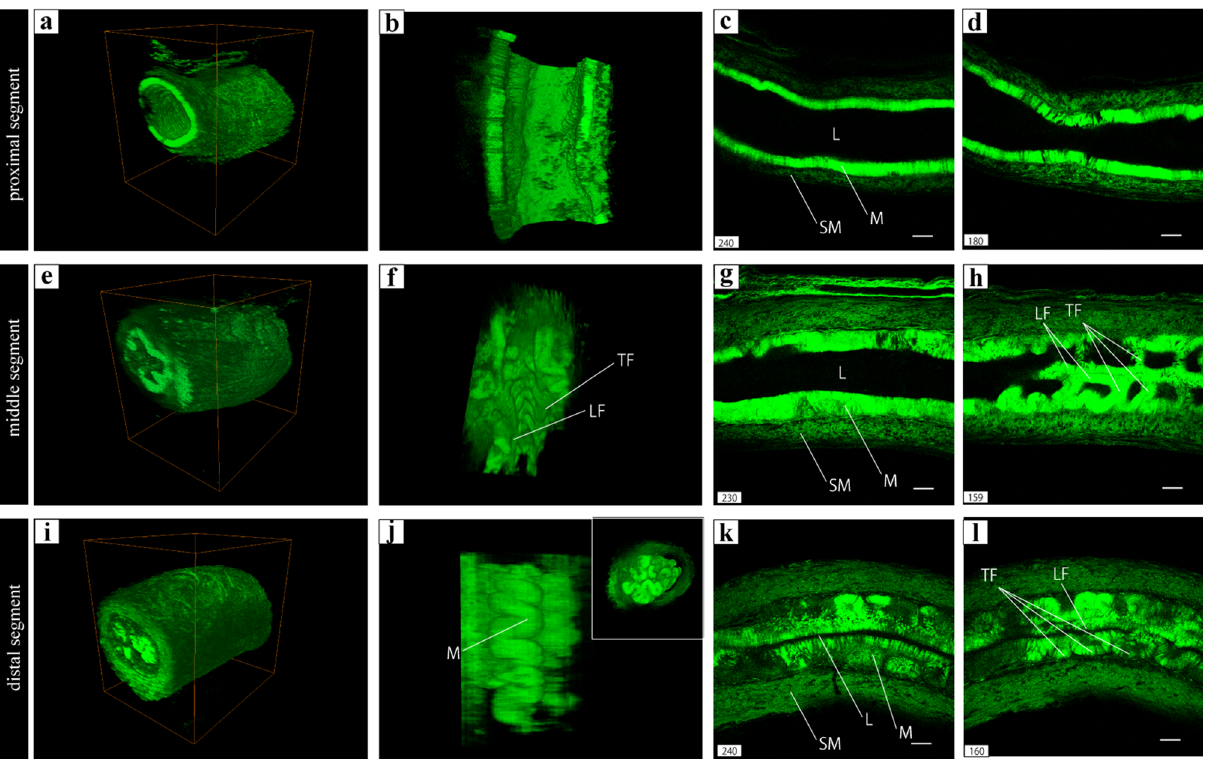
Figure 1. ( a ) The 3D reconstructed overview of the proximal segment of GFP transgenic murine vas deferens. ( b ) Lumens of ( a ). ( c , d ) Sagittal sections including the lumen of ( a ). ( e) : 3D reconstructed overview of the middle segment of GFP transgenic murine vas deferens. ( f ) Lumens of ( e ). ( g , h ) Sagittal sections including the lumen of ( e ). ( i) : 3D reconstructed overview of the distal segment of GFP transgenic murine vas deferens. ( j ): Side view of the mucosa area of ( i ). Front view of the mucosa area of ( i ) (inset at the upper right corner of ( j )). ( k , l ): Sagittal sections including the lumen of ( i ). The same images following deconvolution and 3D reconstruction using the Avizo software (version 9.1.1) available at https:// www. fei. com/ softw are/ avizo 3d/ ( a , b , e , f , i , j ). LF longitudinal fold, TF transverse fold, M mucosa, L lumen, SM smooth muscle. Scale bars: 100 µm ( c , d , g , h , k , l